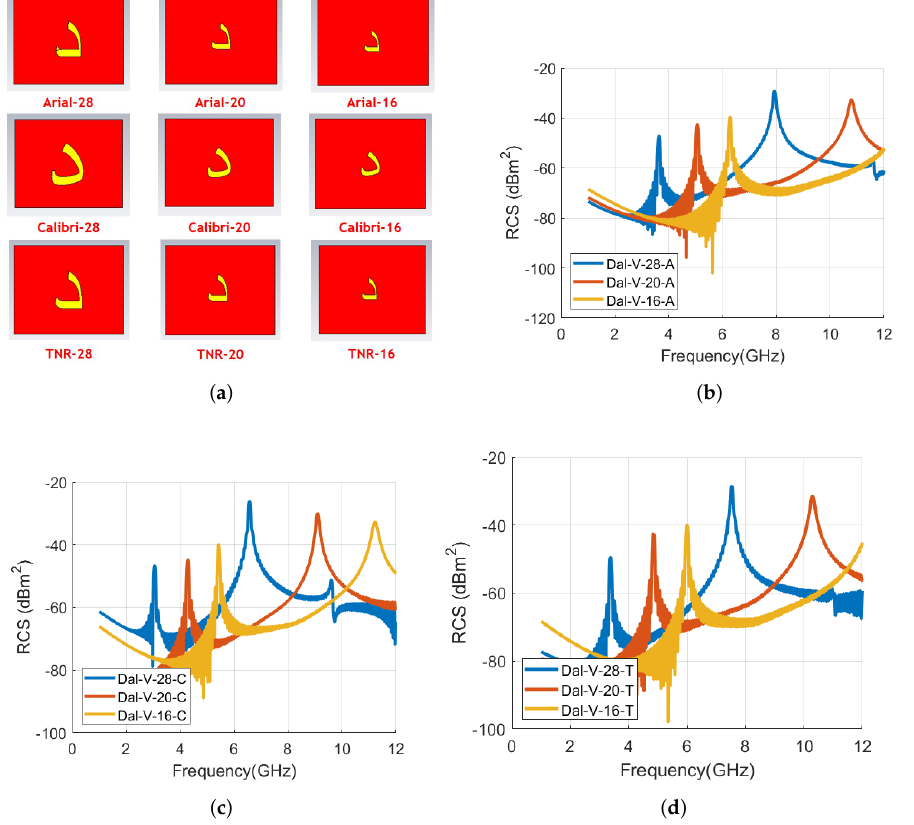
Figure 17. Designed letters and comparison of RCS results of alphabet X tag for vertical polarization with various font types and sizes: ( a ) Designed letter X tag with various fonts and sizes; ( b ) RCS results of Arial font with 28, 20, and 16 sizes; ( c ) RCS results of Calibri font with 28, 20, and 16 sizes; and ( d ) RCS results of Times New Roman (TNR) font with 28, 20, and 16 sizes.